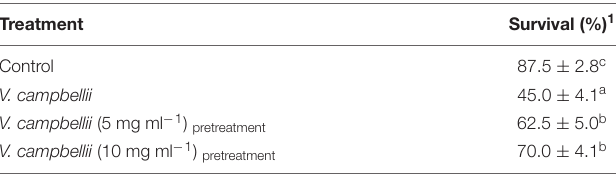
manner, with a 3.4-fold decrease at 5 mg ml − 1 and with a